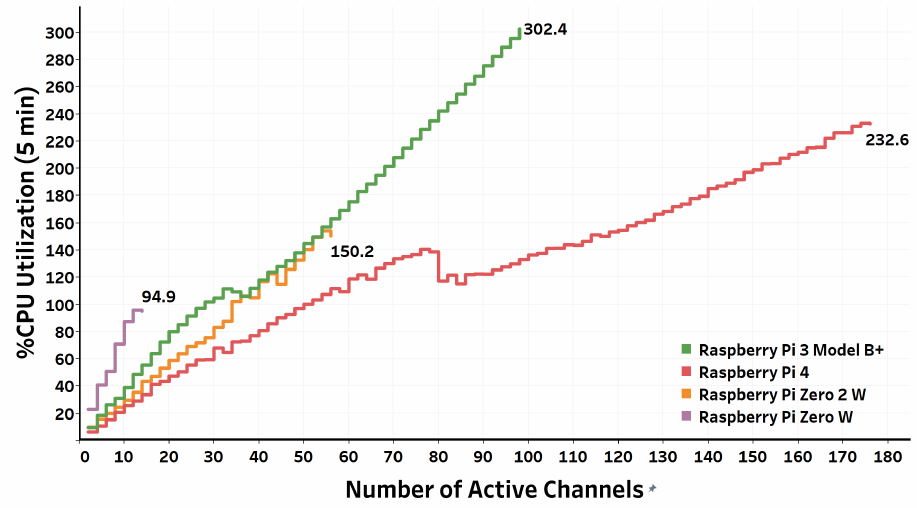
Figure 13. Relation between the number of active channels and the CPU utilization